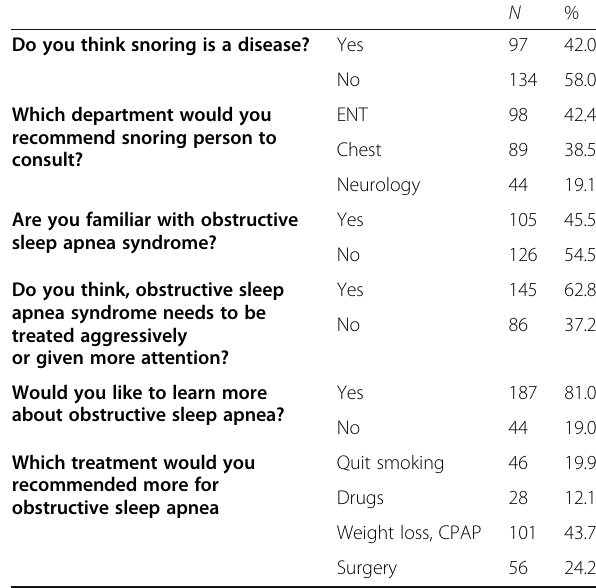
Table 3 Attitude of all studied physicians (no. = 231)